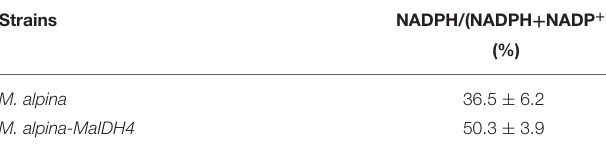
TABLE 4 | NADPH production in M. alpina-MaIDH4 recombinant